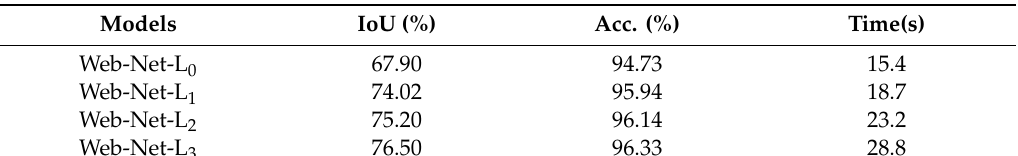
Table 3. Model Pruning.